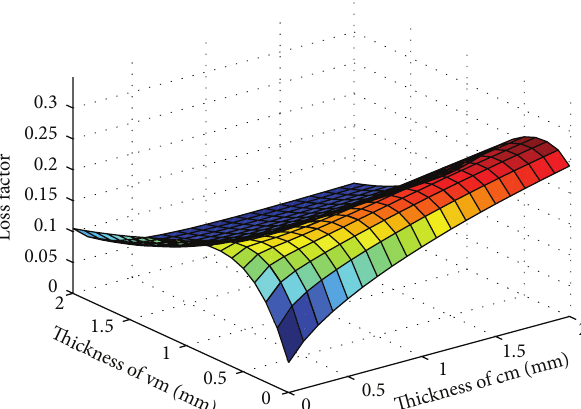
Figure 15: Influence of thickness on the loss factor in 3-layer struc- ture.